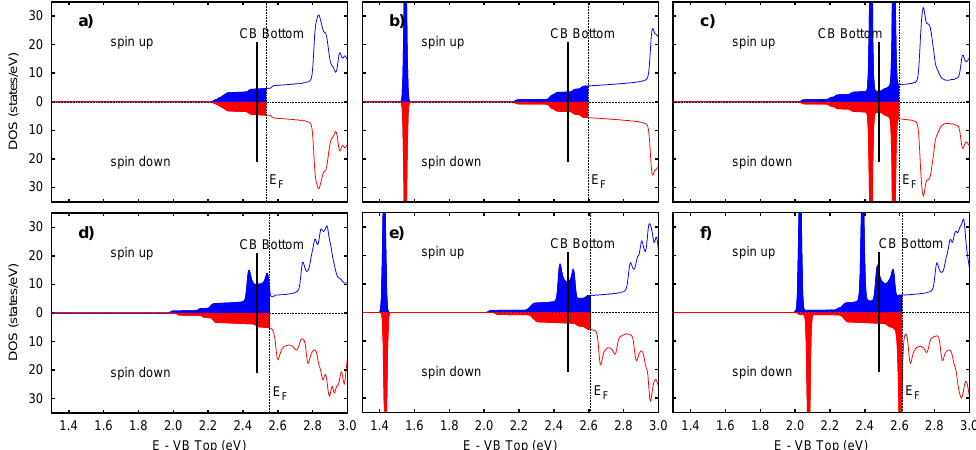
Figure 7. Density of states near the bottom of the conduction bands (CB), for surface and adsorbate systems: ( a ) Stoichiometric surface, ( b ) Ace@Surf, ( c ) Tol@Surf, ( d ) Surf-V O , ( e ) Ace@Surf-V O , and ( f ) Tol@Surf-V O . The black vertical line indicates the position of the bottom of the bulk CB (at 2.46 eV from the top of the valence band). The colored parts mark the occupied states. The broadening of the eigenvalues is 0.01